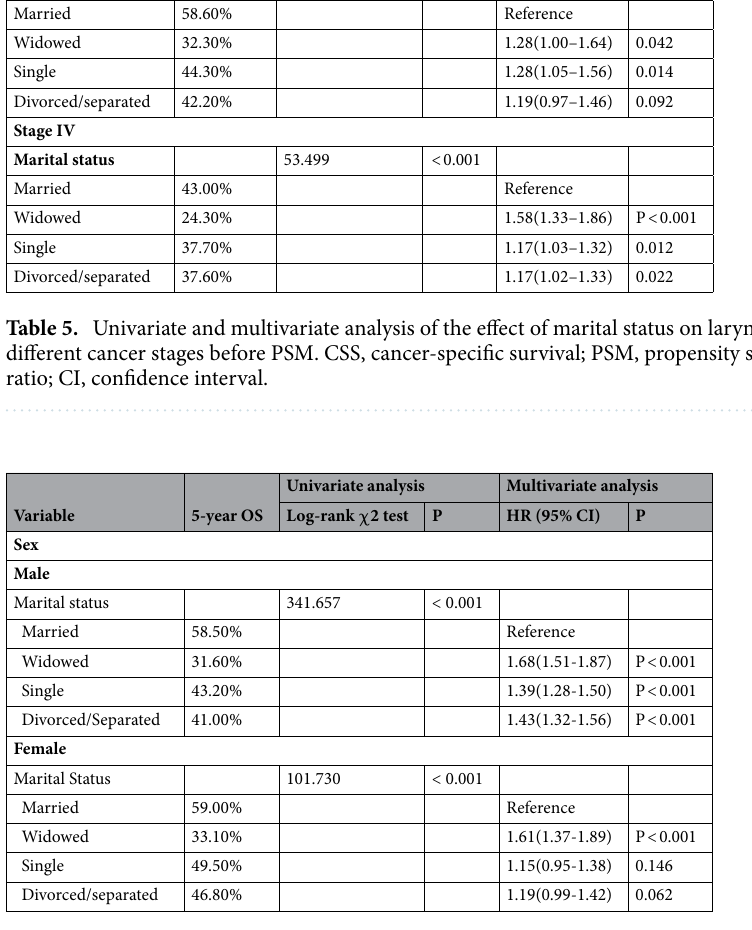
Table 6. Univariate and multivariate analysis of the effect of marital status on laryngeal cancer OS based on different sex before PSM. OS, overall survival; PSM, propensity score matching; HR, hazard ratio; CI, confidence